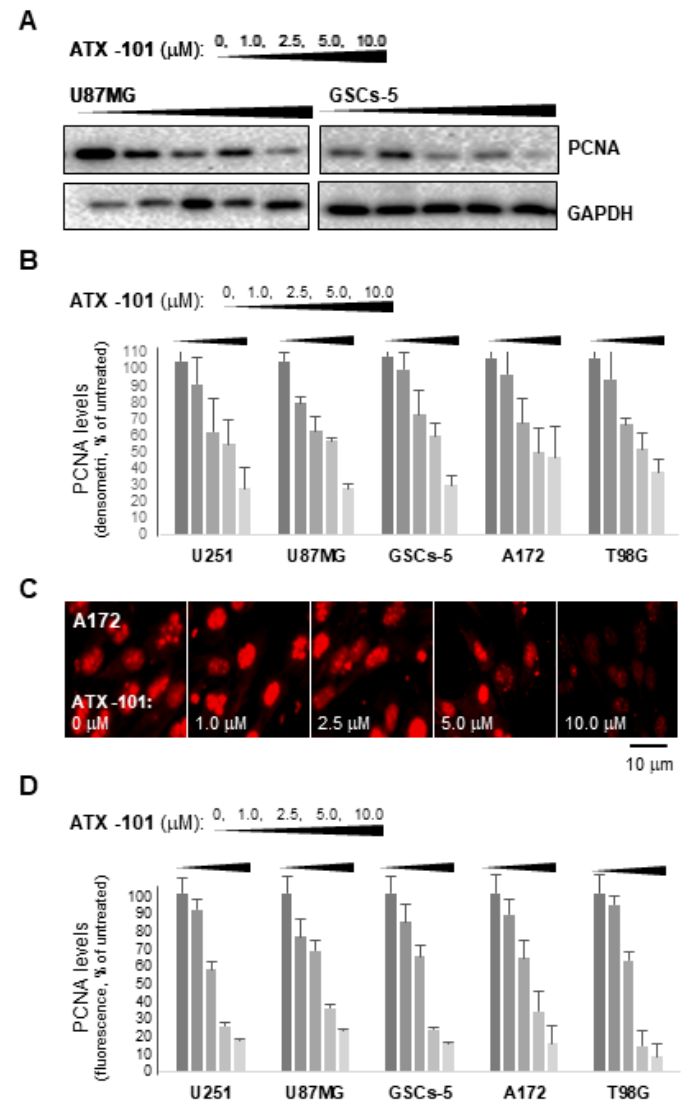
Figure 2. ATX-101 inhibits total PCNA expression in GBM cell models. ( A ) Representative Western blots performed on cell lysates collected from U87MG and GSCs-5 cells treated with ATX-101 (1–10 µ M) for 24 h. ( B ) Quantifications of PCNA levels (normalized to GAPDH) in U251, U87MG, GSCs-5, A172, and T98G after treatment with ATX-101 (1–10 µ M) for 24 h. Uncropped Western blots are shown in Supplementary Figure S3. ( C ) Immunofluorescence staining of PCNA in A172 cells treated with ATX-101 (1–10 µ M) for 24 h. Magnification, × 50; bar corresponds to 10 µ m. ( D ) Quantifi- cations of fluorescence in A172 in ATX-101 treated cells (1.0, 2.5, 5.0, 10.0 µ M) and in similarly treated U251, U87MG, GSCs-5, and T98G cells. Data presented are the mean ±